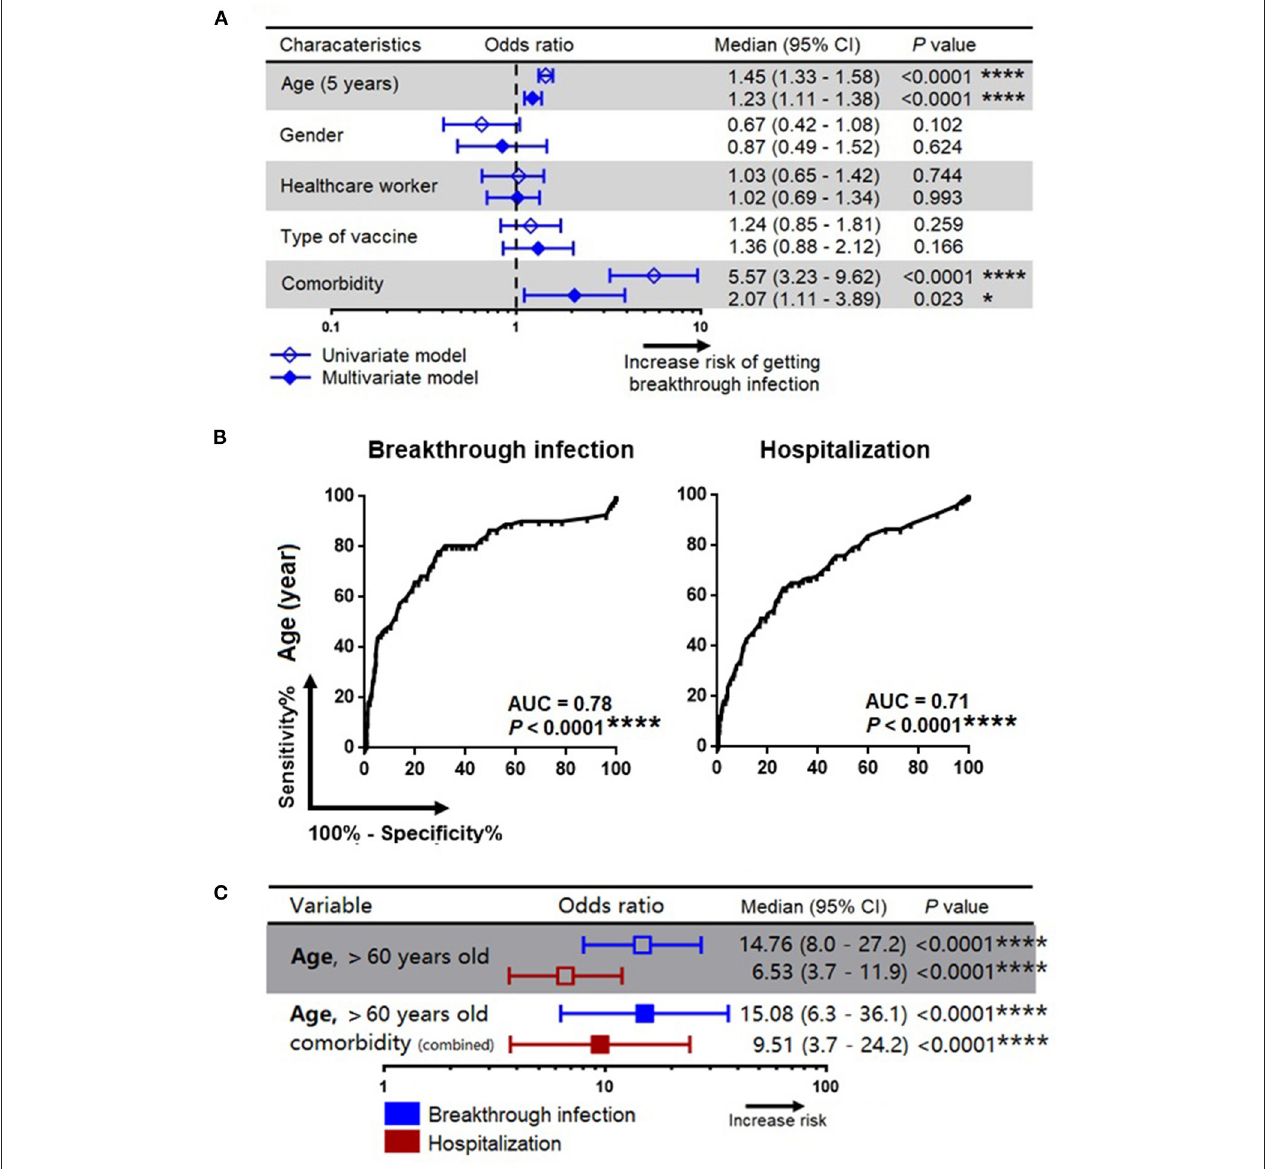
FIGURE 2 | Association of patients’ characteristics with risk for development of breakthrough infection and hospitalization. (A) A simple and adjusted binary regression models assessing the factors that associated with breakthrough infection. Odds ratios for values below or above threshold levels were displayed in a forest plot; median and 95% CI were calculated. (B) Receiver operating characteristics analysis for prediction of breakthrough infection and hospitalization. (C) Association of age and comorbidity with the risk of breakthrough infection and hospitalization. CI, confidence interval; Comorbidity refers to diabetes mellitus, cardiovascular disease, hypertension and other underlying medical conditions as detailed in Table 1 ; *, **, ***, *** represent P < 0.05, < 0.01, < 0.001, < 0.0001,